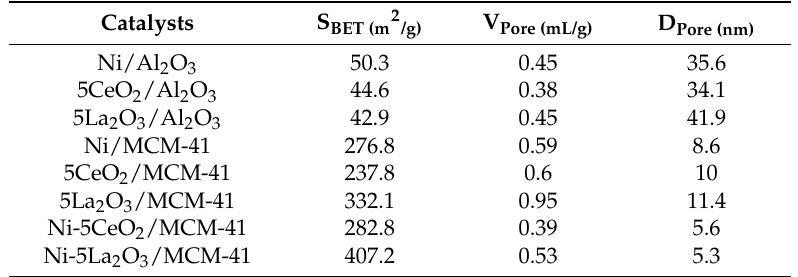
Figure 3. N 2 adsorption–desorption isotherms (a) and pore size distribution (b) of the synthesized catalysts. Table 1. Textural properties of the catalysts. BET—Brunauer–Emmett–Teller.